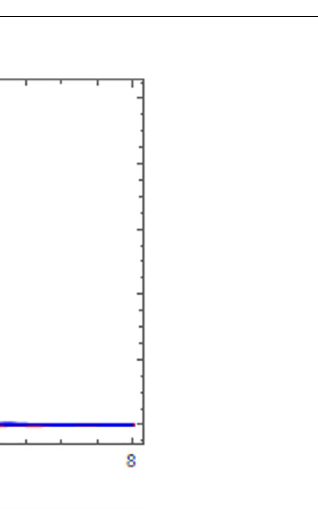
Fig 10. Impact of stretching parameter on thermal and concentration